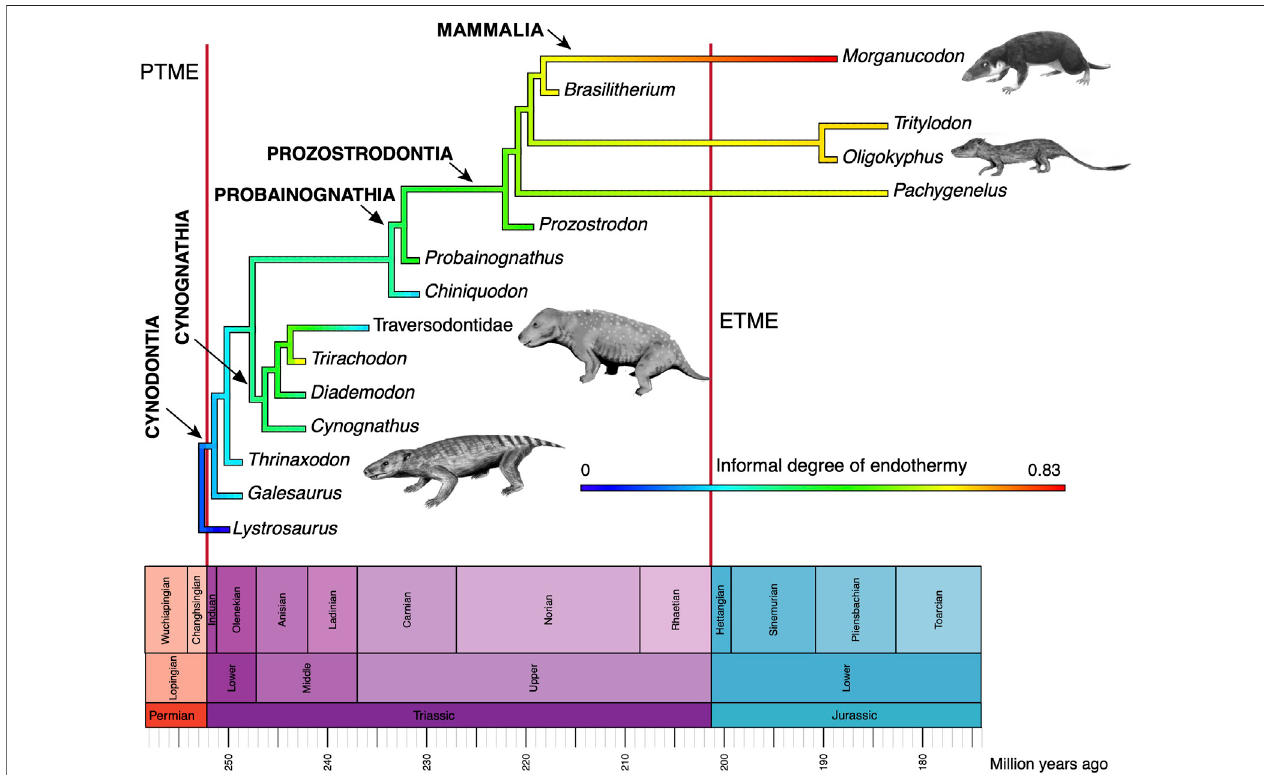
FIGURE 8 | Evolution of endothermy among synapsids, showing a range of values of an informal metric of endothermy (data in Benton, 2021, table 1). The small animal images are by Nobu Tamura ( Thrinaxodon , Oligokyphus , Exaeretodon ) and FunkMonk ( Morganucodon ), all Creative Commons (Wikimedia).